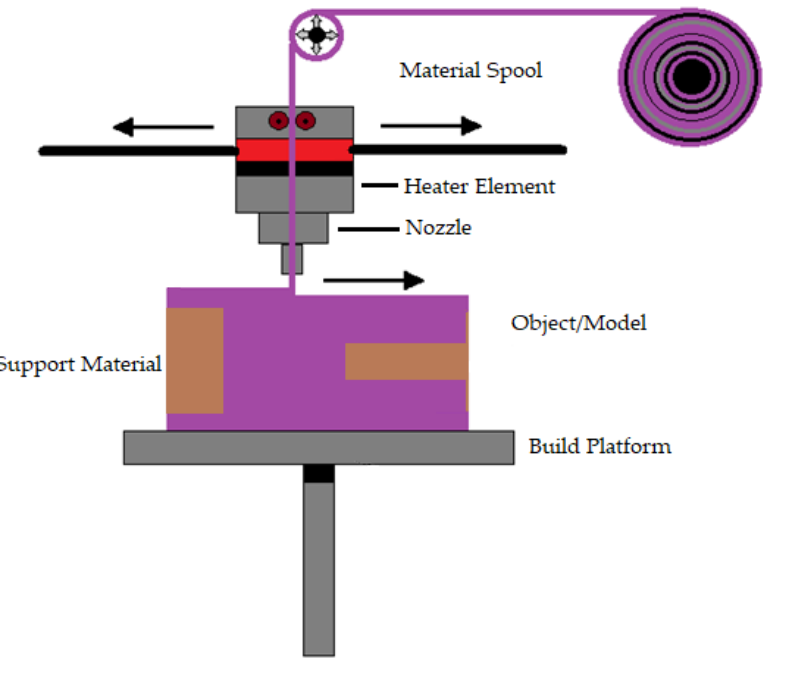
Figure 2. Representation of material extrusion.